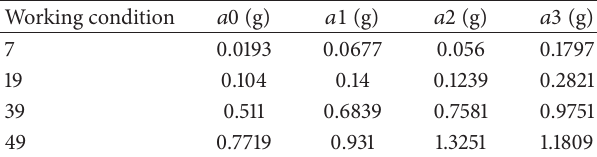
data were collected for every working condition. Sampling frequency was set to 512 Hz. The 0# acceleration sensor indi- cated the actual acceleration on the vibration table surface. The 1#–3# sensors indicated the specimen’s bottom, middle, and top acceleration, respectively.